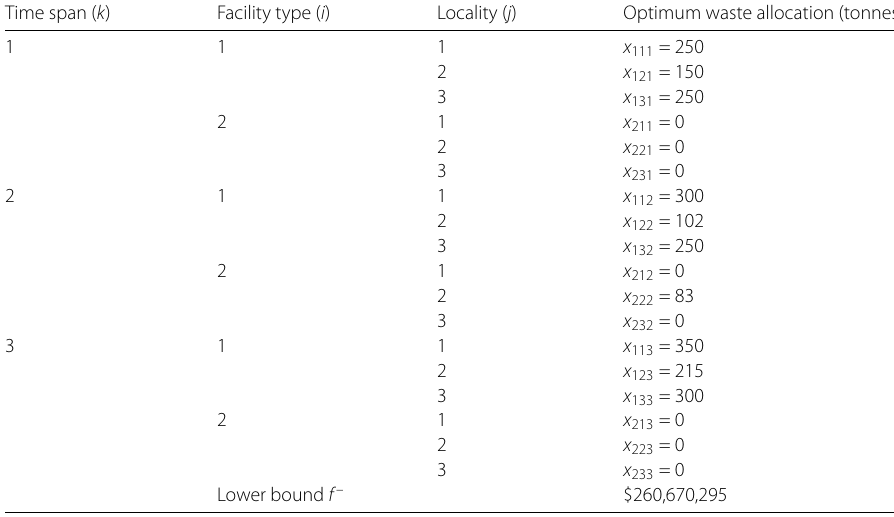
Table 6 Optimal values of variables for lower bound f – Time span ( k